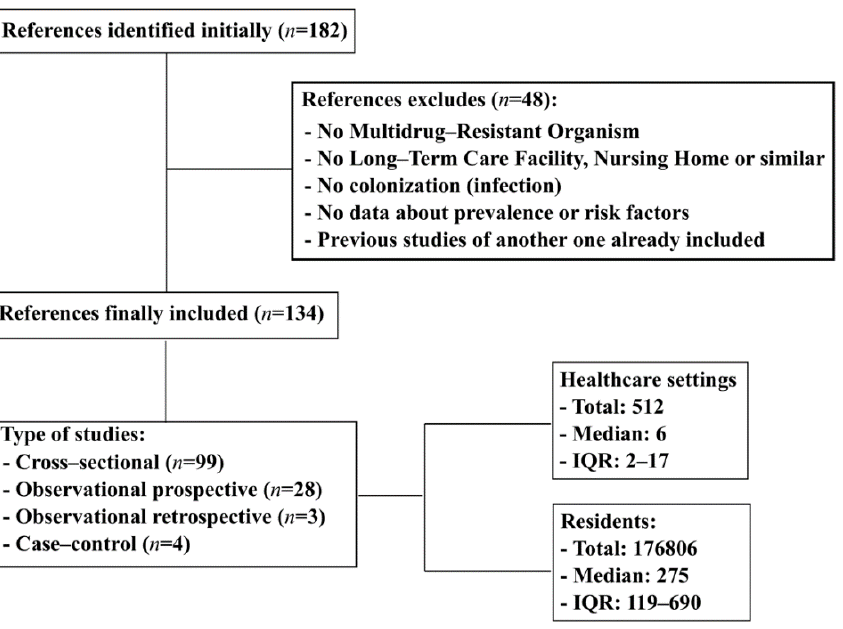
Figure 1. Flowchart search strategy. IQR, interquartile range.